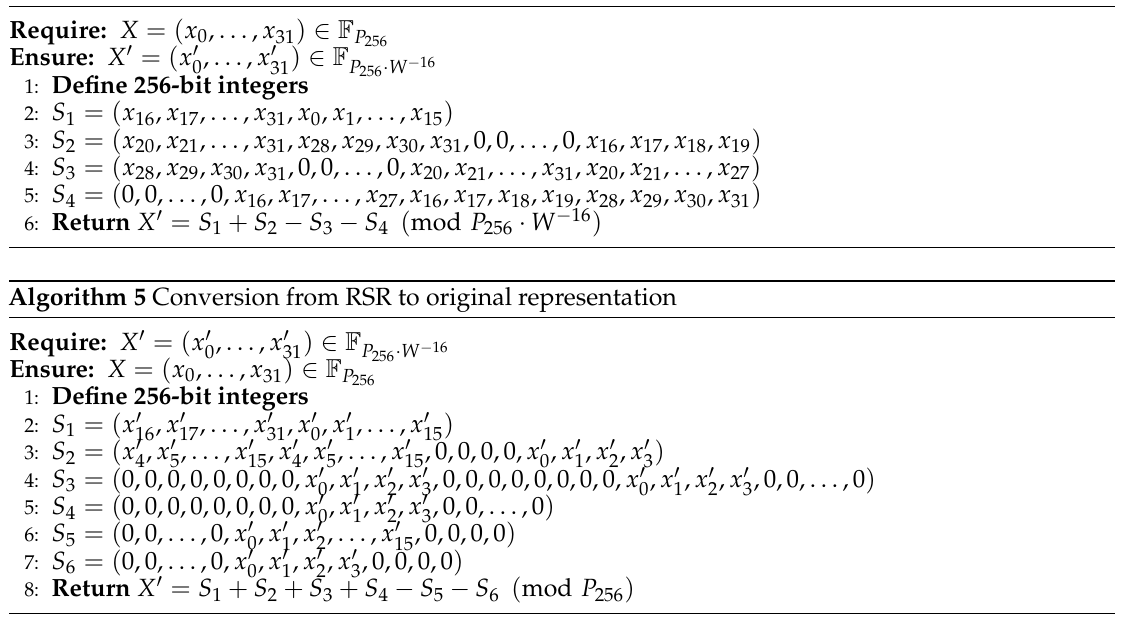
Algorithm 4 Conversion from original representation to RSR